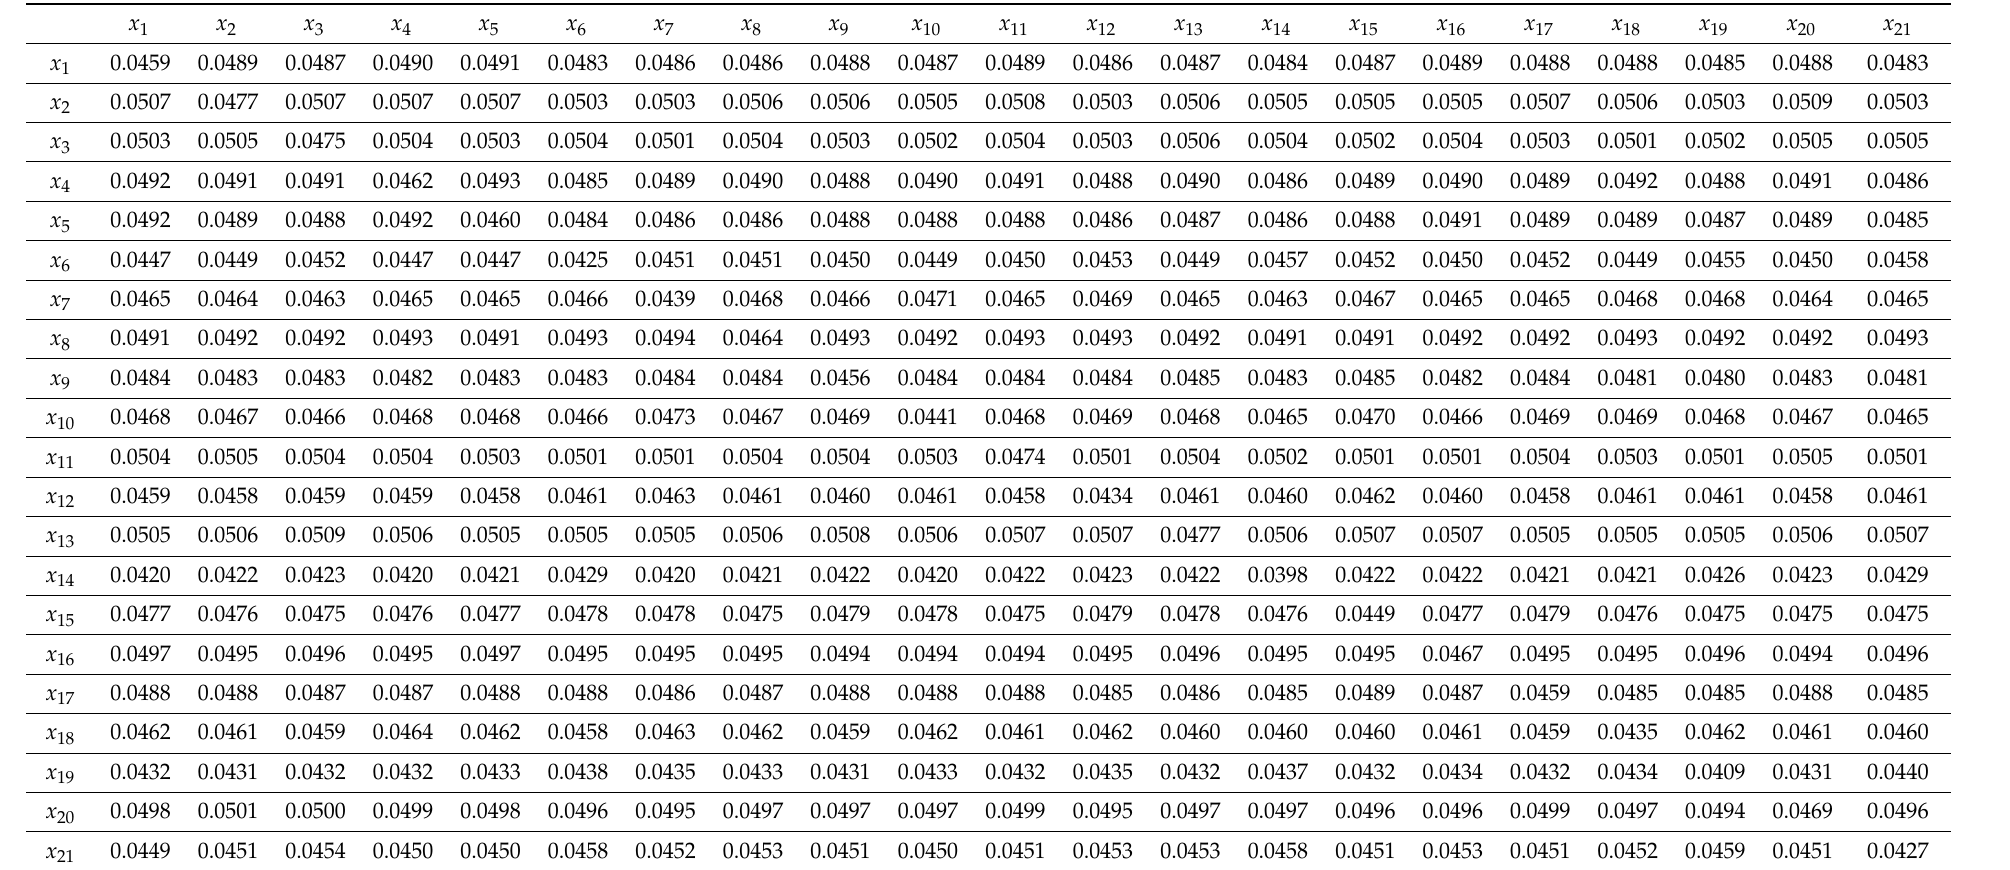
Table A5. The weighted supermatrix for